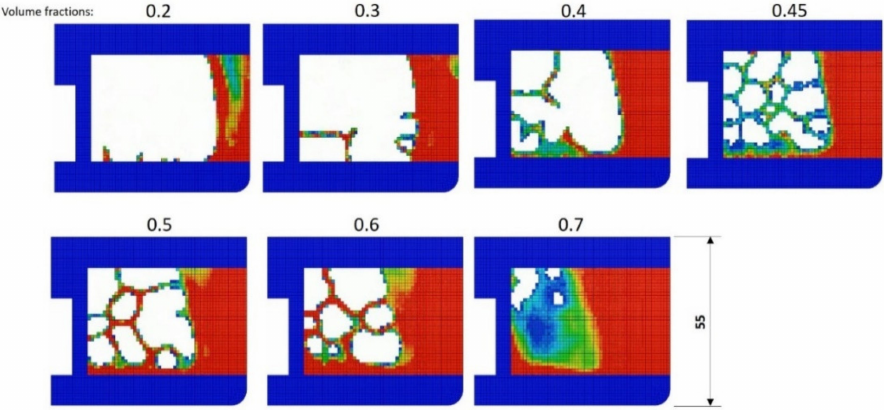
Figure 9. Topology optimization of the U-bend tool (Figure 11) with different volume fractions [130].